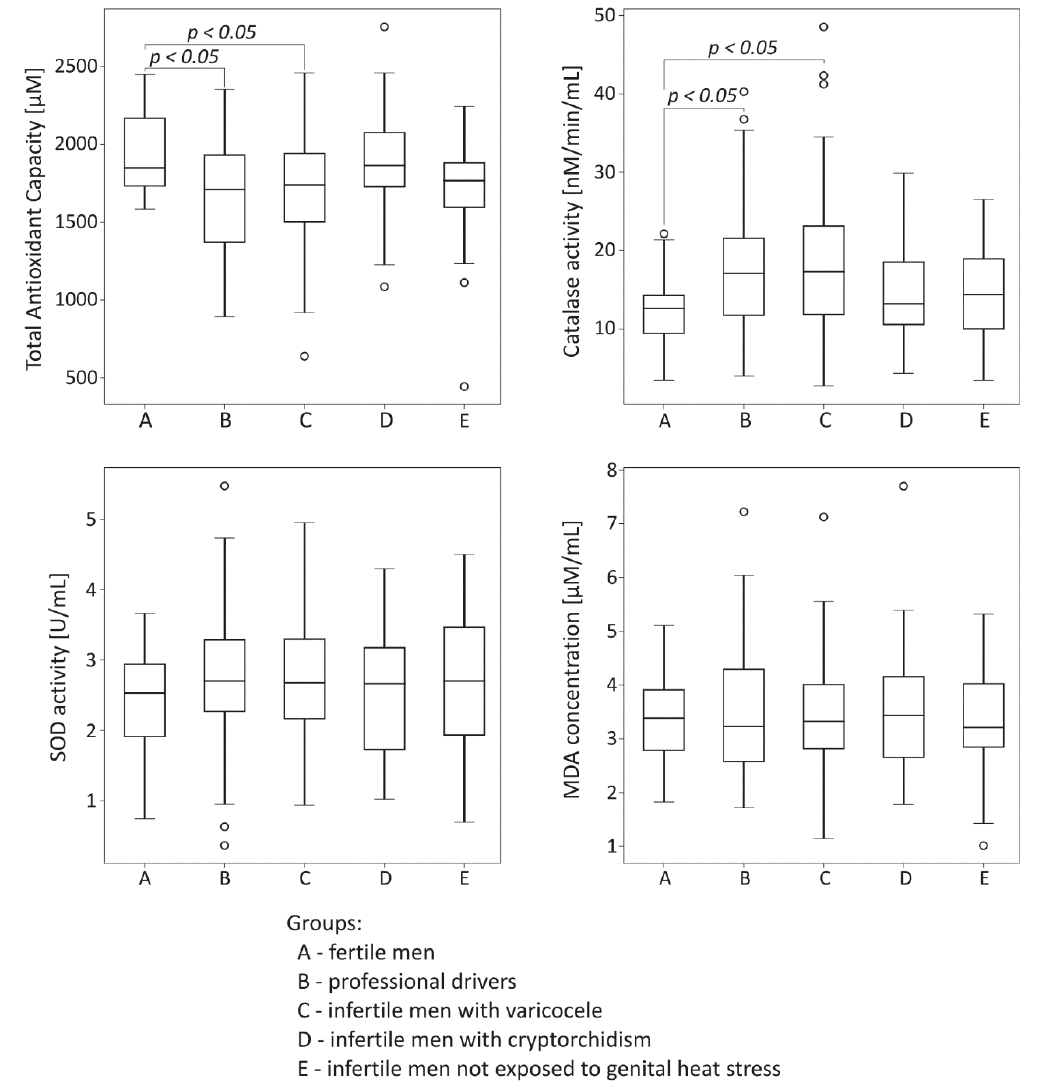
Figure 2. Comparison of seminal total oxidant capacity, catalase activity, superoxide dismutase (SOD) activity, and malondialdehyde (MDA) concentration among the studied groups. The results are expressed as the median, Q1–Q3, and range. p < 0.05 calculated using the Dunn test with Holm’s correction compared to the control group. ◦ —data points with values smaller than Q1 − 1.5 × interquartile range or greater than Q3 + 1.5 × interquartile